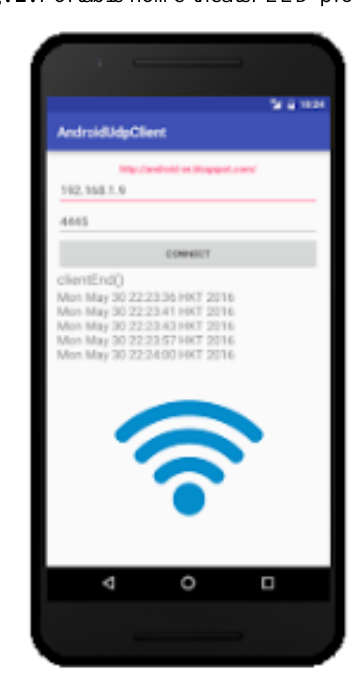
Fig. 2. Portable home theater LED projector